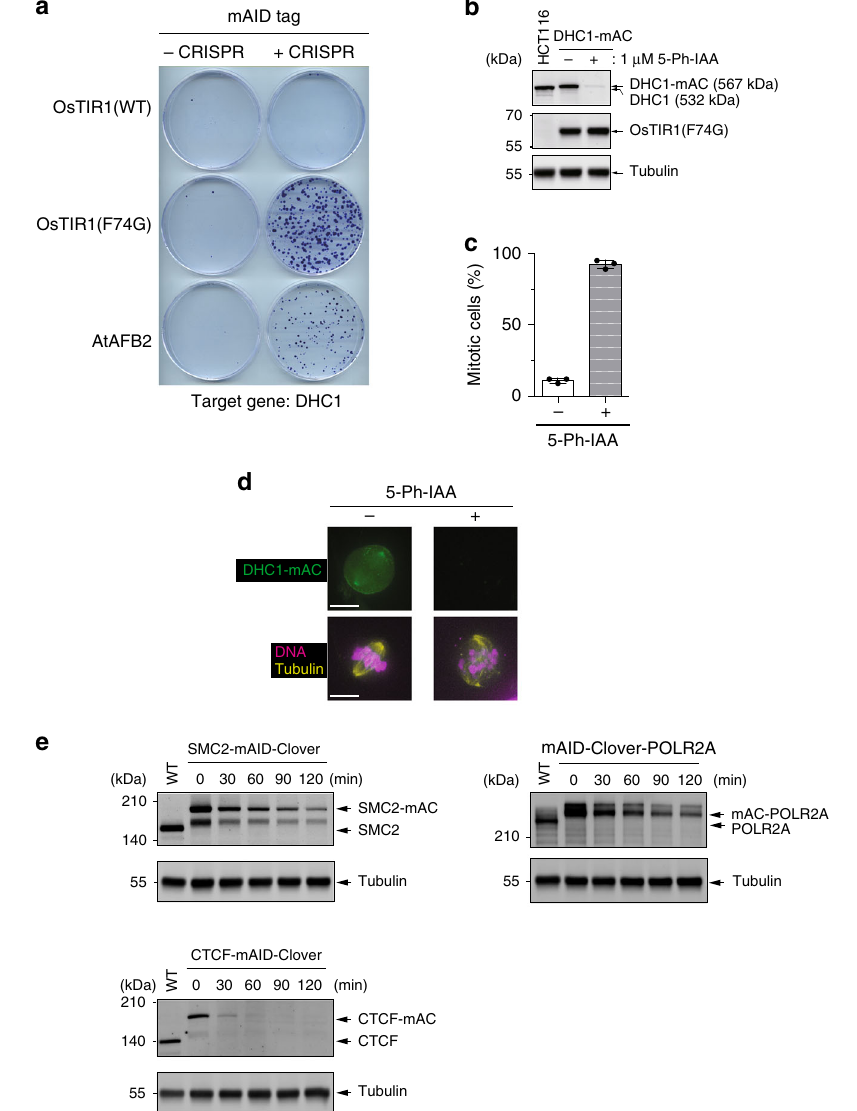
Fig. 4 The AID2 system can generate conditional mutant cell lines for genes that were not possible to modify with the original AID system. a Colony formation of HCT116 cells expressing OsTIR1(WT), OsTIR1(F74G) or AtAFB2 after transfecting DHC1-tagging donors and a targeting CRISPR plasmid. Colonies were formed in the presence of 700 µ g/ml of neomycin and 100 µ g/ml of hygromycin for 11 days. b DHC1-mAC was induced to degrade in HCT116 cells expressing OsTIR1(F74G) by the addition of 1 µ M 5-Ph-IAA for 6 h. DHC1-mAC and OsTIR1(F74G) were separated and detected by anti- DHC1 and -OsTIR1antibodies, respectively. Tubulin was used as a loading control. We repeated this experiment three times and obtained consistent results. c The mitotic index after DHC1-mAC depletion for 24 h. Data are presented as mean values ± SD ( n = 3 independent experiments). d Microscopic image of mitotic cells after DHC1-mAC depletion. DHC1-mAC, DNA and tubulin were visualized. We repeated this experiment twice and obtained consistent results. Scale bars show 11 µ m. e Indicated genes were tagged with mAID-Clover in HCT116 cells expressing OsTIR1(F74G). They were treated with 1 µ M 5-Ph-IAA to take a time-course sample at the indicated time points. Proteins were separated and detected using a speci fi c antibody. Tubulin was used as a loading control. We repeated this experiment three times and obtained similar